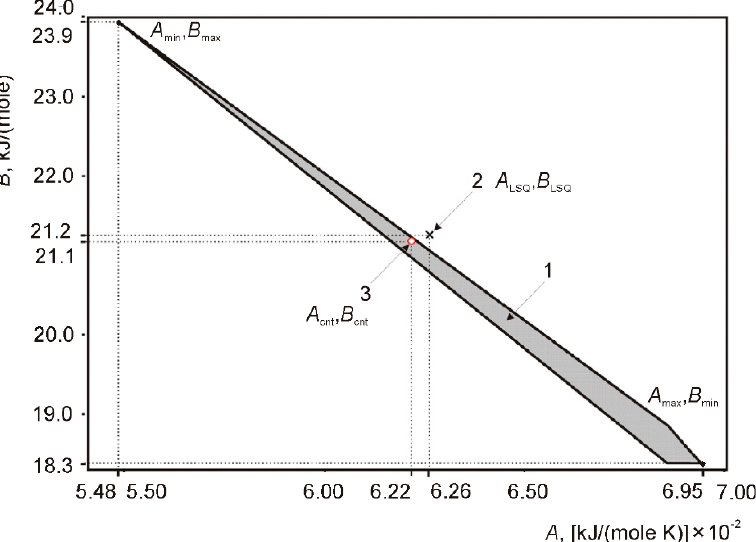
Figure 5. Results of estimation of admissible values of parameters for the approximation function H ( T ) = A * T + B . (1) Information set; (2) LSQM—estimate A LSQ , B LSQ ; (3) central point A cnt and B cnt of the information set. Grey area is an area of possibleA and B coefficientsts according interval analysis, red circle is a point of fiiting coefficients related to to LSQM